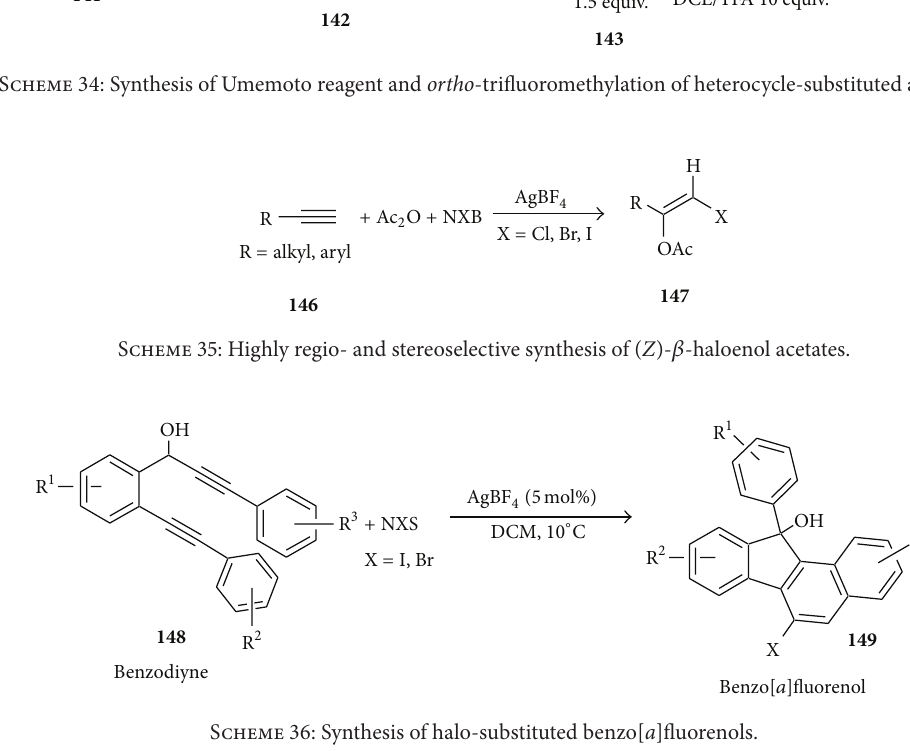
Scheme 36: Synthesis of halo-substituted benzo[ a